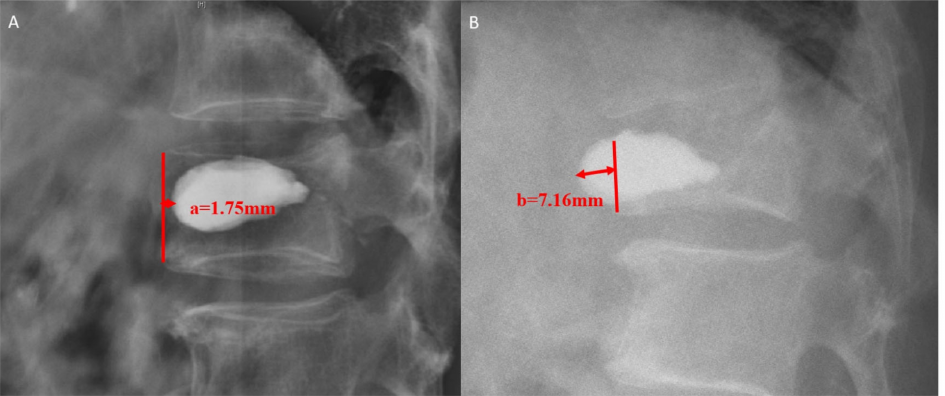
Figure 2. ( A ) The patient showed well-located bone cement, and the distance between the cement’s anterior edge and the anterior wall of the vertebral body was 1.75 mm before discharge. ( B ) The patient showed that the distance was 7.16 mm at follow-up. By taking the anterior wall of the vertebral body as a reference, the movement of the anterior edge of bone cement was 8.91 mm, and the patient met the criteria for radiographic diagnosis of